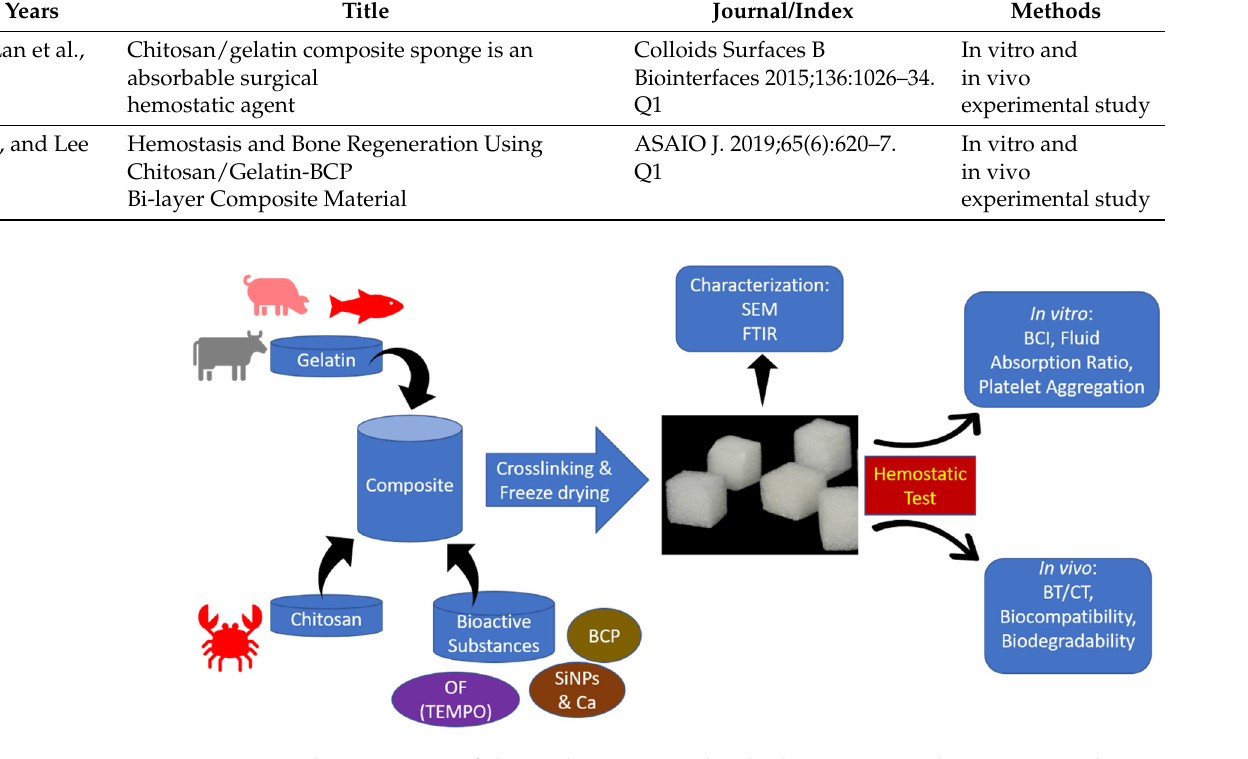
Figure 2. Schematic view of the studies (OF: Oxidized Fibers, SiNPs: Silica Nanoparticles, Ca: Calcium, BCP: Biphasic Calcium Phosphate, SEM: Scanning Electron Microscope, FTIR: Fourier Transform Infrared, BCI: Blood Clotting Index, BT/CT: Bleeding Time/Clotting Time). Data collection from each article was conducted by two reviewers (HH and AC) if